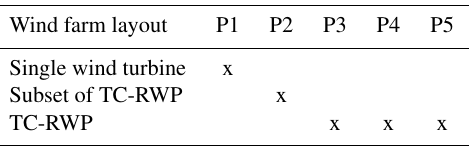
Table 1. Overview of the participants (participant IDs P1–P5) per considered layout. The layout of the subset and full TotalControl Reference Wind Power Plant (TC-RWP) with 10 and 32 wind tur- bines, respectively, is indicated when the results are presented in Sect. 4. Wind farm layout P1 P2 P3 P4 P5 Single wind turbine x Subset of TC-RWP